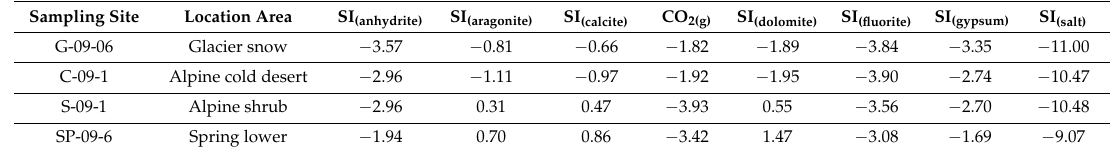
Table 1. Saturation indices on water samples from the aquifers in the study area.